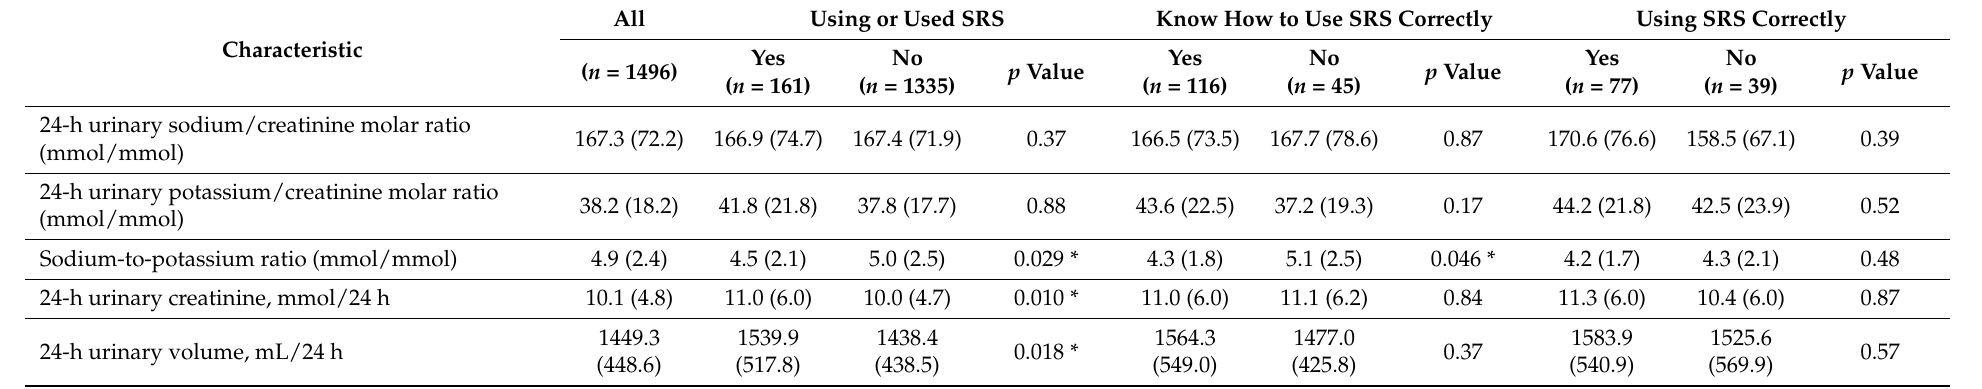
Table 4. Urinary excretion of electrolytes from 24-h urine specimens by salt-restriction spoon status in subset of participants [ n =1496].